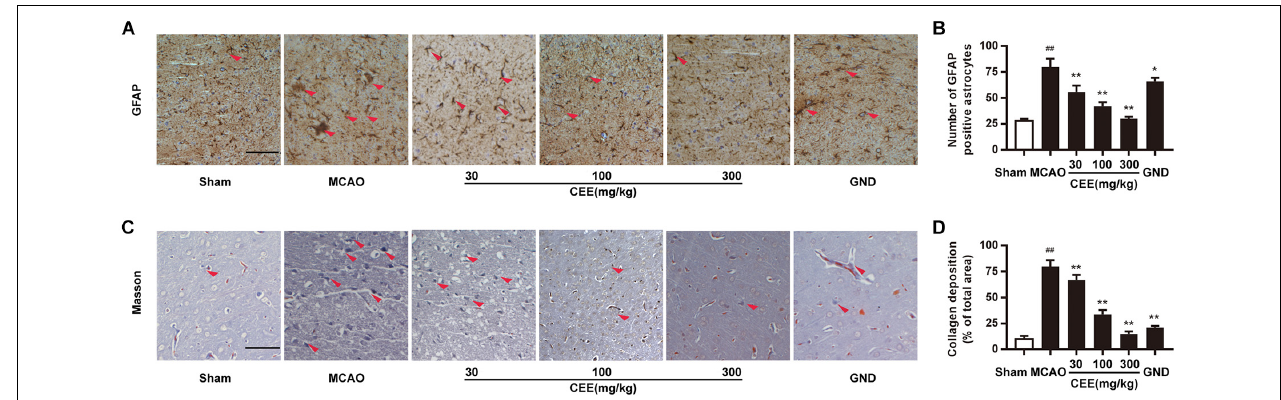
FIGURE 4 | Caesalpinia sappan ethanolic extract suppresses astroglial activation and collagen deposition in MCAO rats. (A) GFAP expression in brains as detected by immunohistochemical staining assay using a specific antibody for GFAP (scale bar: 50 µ m). (B) Quantitative assessment of GFAP positive astrocytes in rat brain cortex penumbra per field. (C) Collagen deposition as determined through Masson staining assay (scale bar: 50 µ m). (D) Quantitative assessment of collagen deposition area in rat brain cortex penumbra per field. Three rats in each group and three slices for each rat were examined for Masson staining and IHC assay. Data are expressed as mean ± SD . ## P < 0.01 vs. sham group, ∗∗ P < 0.01, ∗ P < 0.05 vs. MCAO